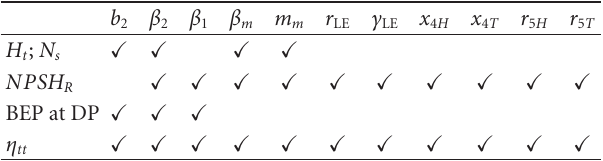
Table 1: Degrees of freedom and their influence on pump’s